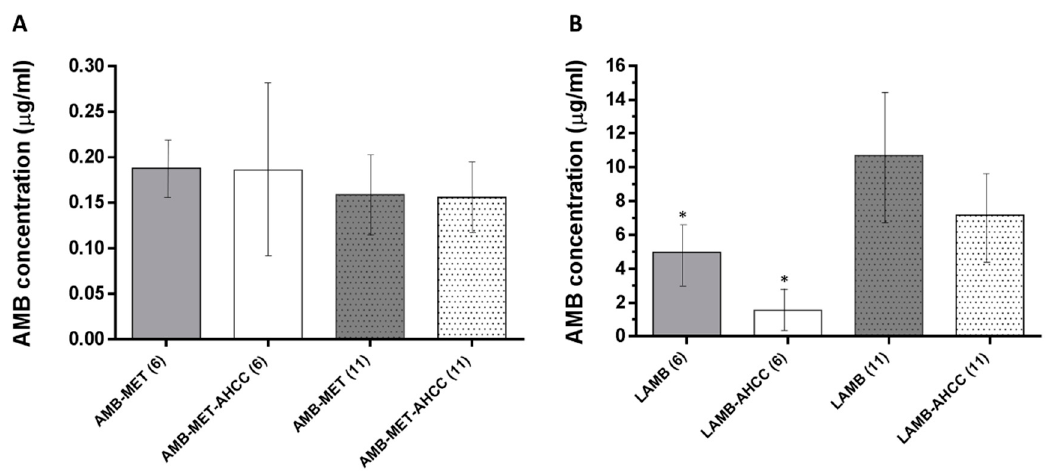
Figure 2. AMB concentration in plasma after day 6 (6) and day 11 (11) post-infection. ( A ) Animals treated with AMB-MET with and without AHCC ® . ( B ) Animals treated with LAMB with and without AHCC ® . * P -value< 0.05 Day 6 vs day 11 post-infection.